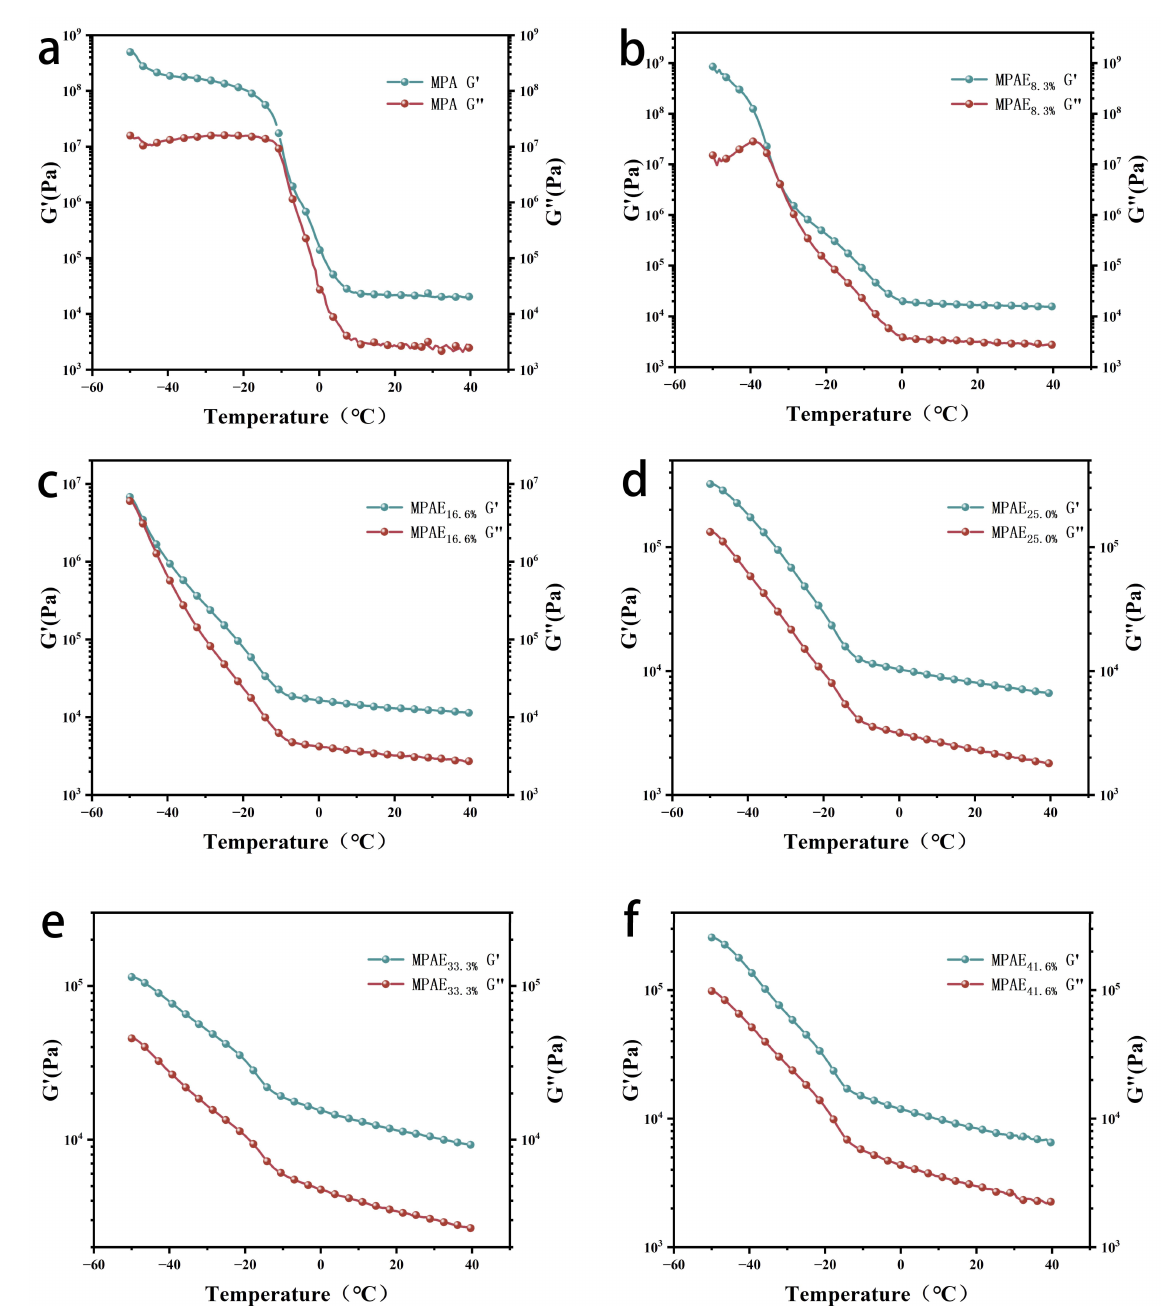
Figure 7. Plots of energy storage modulus (G’) and loss modulus (G”) for different volume fractions of PAEM (( a ) 0%, ( b ) 8.3%, ( c ) 16.6%, ( d ) 25%, ( e ) 33.3%, and ( f ) 41.6%) at temperatures ranging from − 50 to 40 ◦